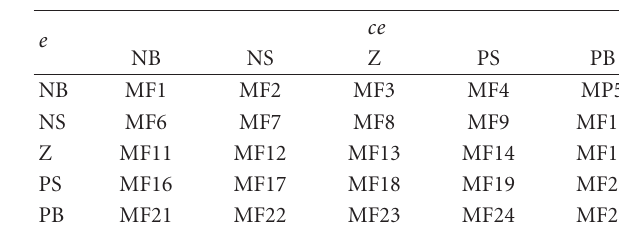
Table 5: Proposed GA ANFIS control